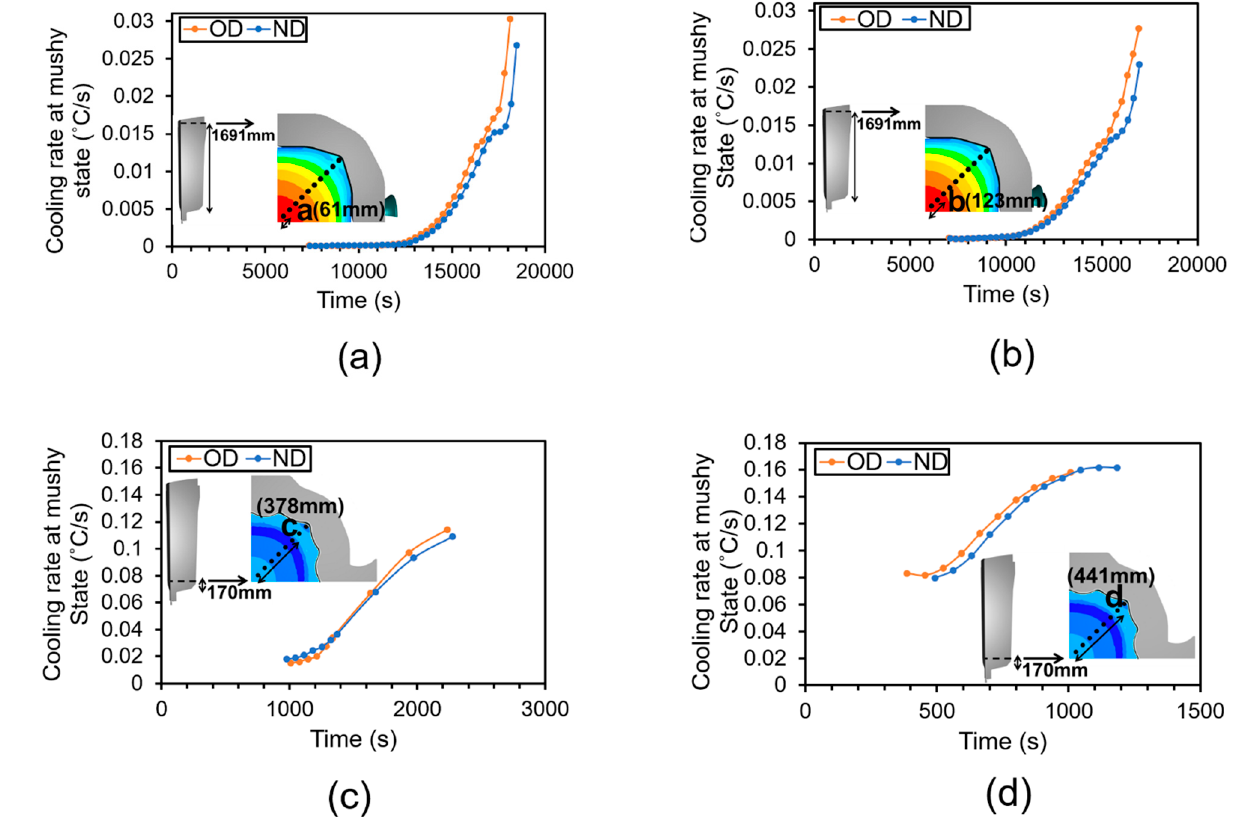
Figure 12. Cooling rate of the liquid at a mushy state in OD and ND: ( a ) 61 mm in a radial direction from the center at the hot top area (height of 1691 mm from the bottom), ( b ) 123 mm in a radial direction from the center at the hot top area (height of 1691 mm from the bottom), ( c ) 378 mm in a radial direction from the center of the ingot at the ingot body bottom part (height of 170 mm from the bottom), and ( d ) 441 mm in a radial direction from the center of the ingot at the ingot body bottom part (height of 170 mm from the bottom) .